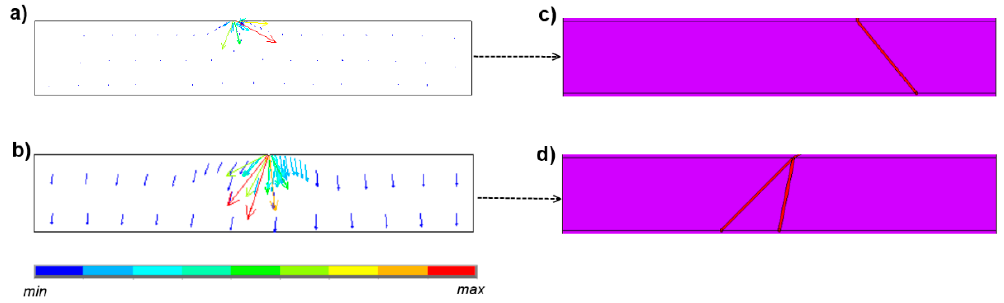
Figure 9. Vectors of the electric field intensity ( a ), ( b ) and streamer models ( c ), ( d ) in subsequent layers of the discharge space.